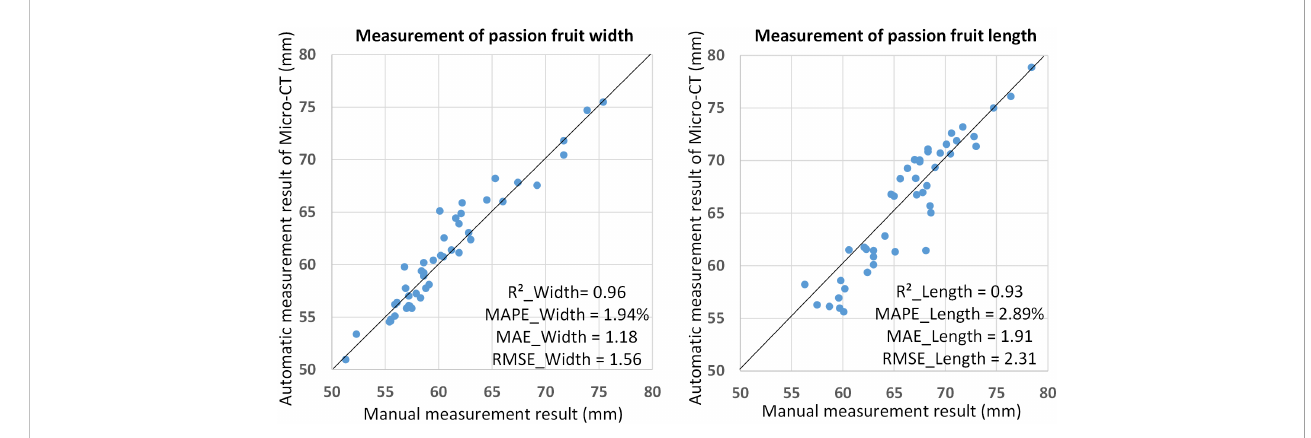
FIGURE 9 Automatic and manual measurement results of passion fruit length and